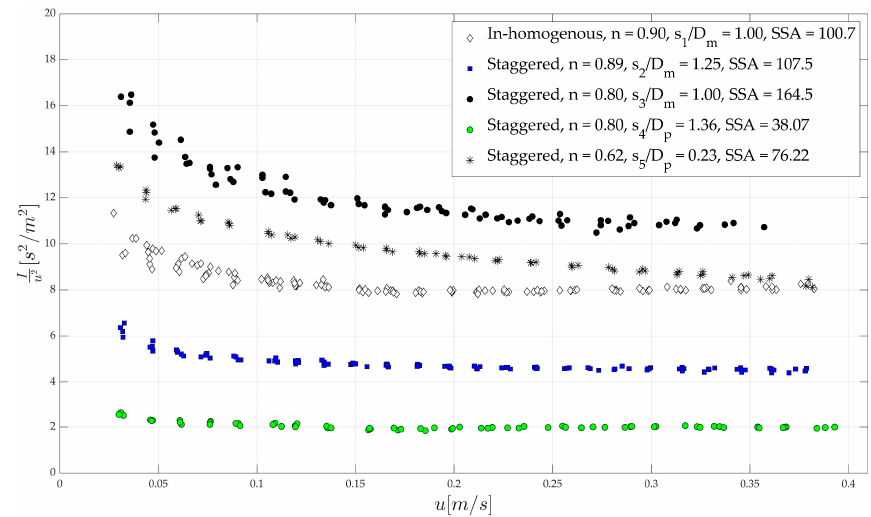
Figure 7. The relation between I / u 2 and u .